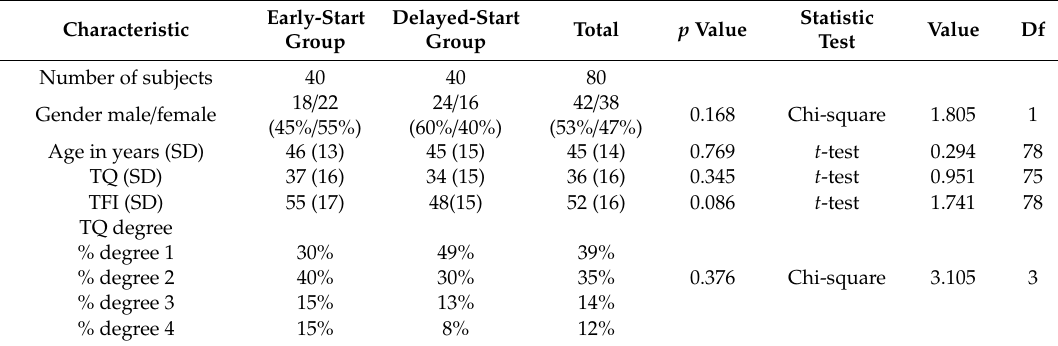
Table 1. Baseline characteristics of the early start group and the delayed start